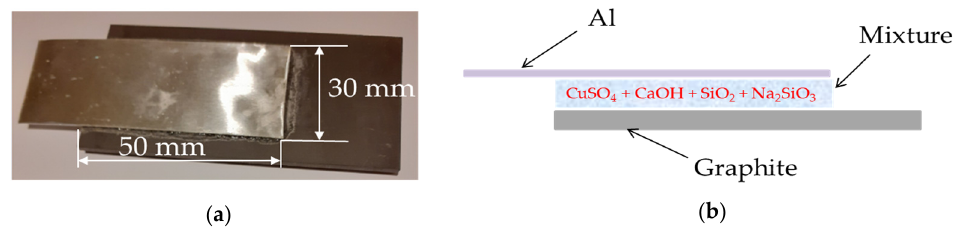
Figure 1. Thermoelectric generator made: ( a ) photo; ( b ) schematic representation.